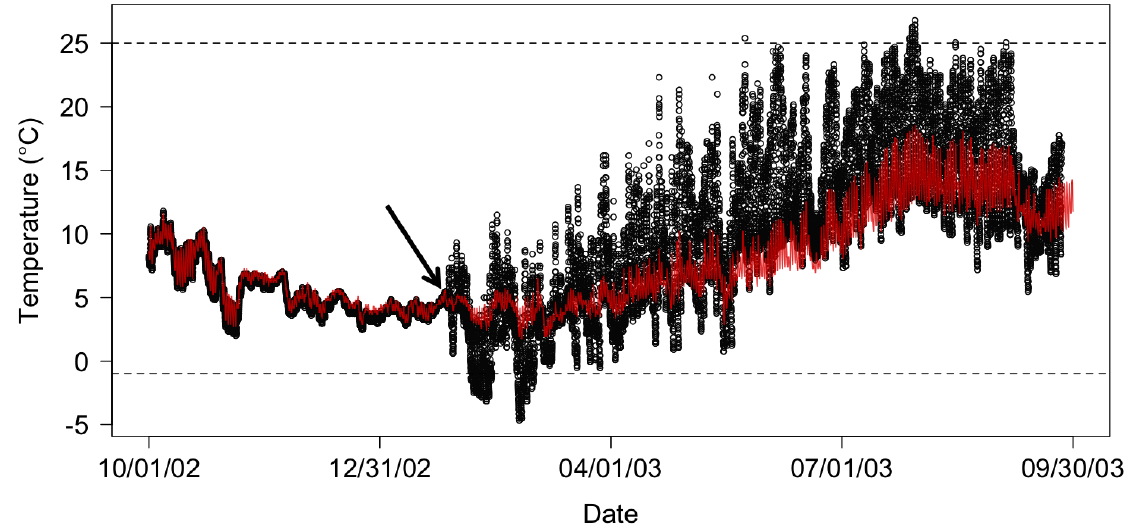
Figure 2. Identifying a dewatering event by comparing nearby